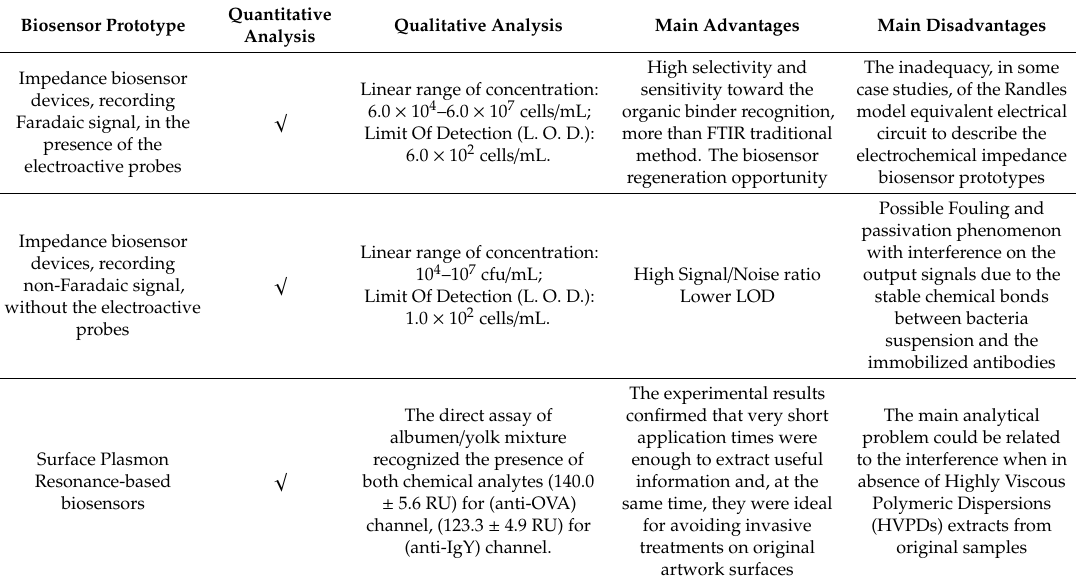
Table 6. Summary of the best analytical performances for the electrochemical